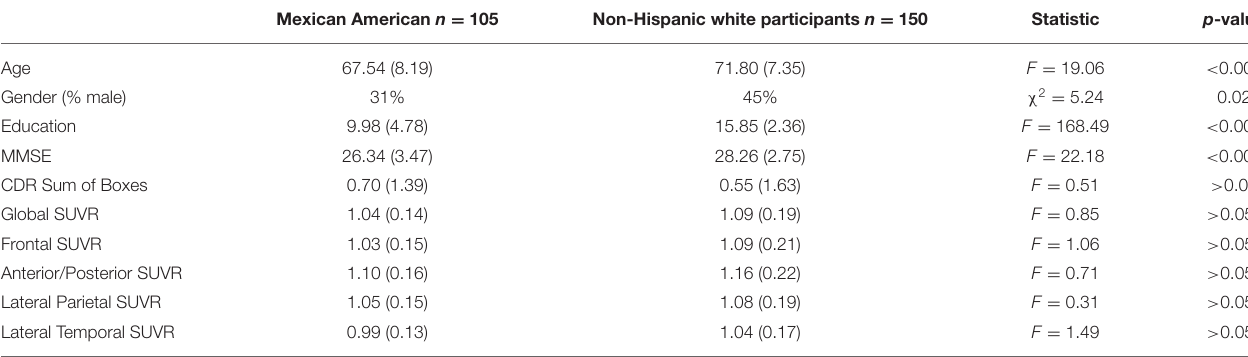
TABLE 1 | Characteristics of